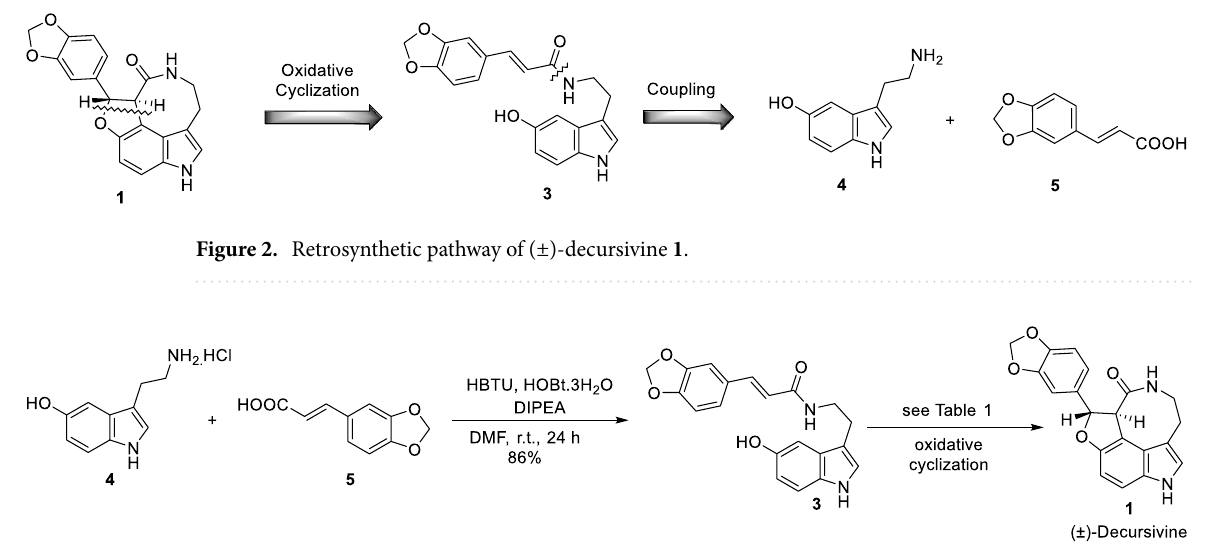
Figure 3. Attempted synthesis of (±)-decursivine 1 . Sr.